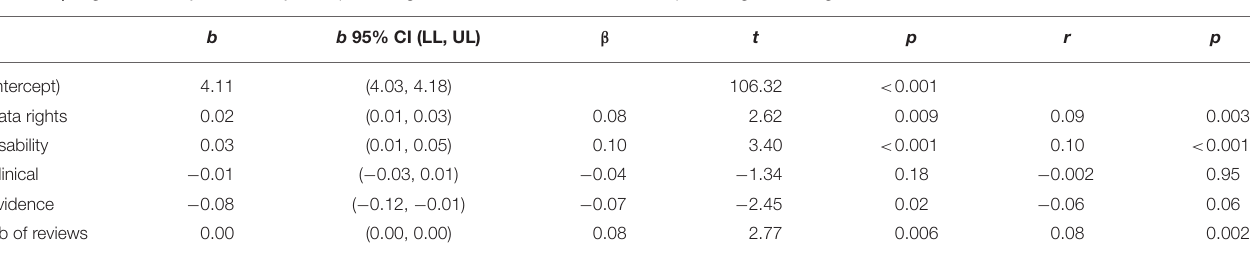
TABLE 3 | Regression analysis summary for expert rating subscales and number of reviews predicting user